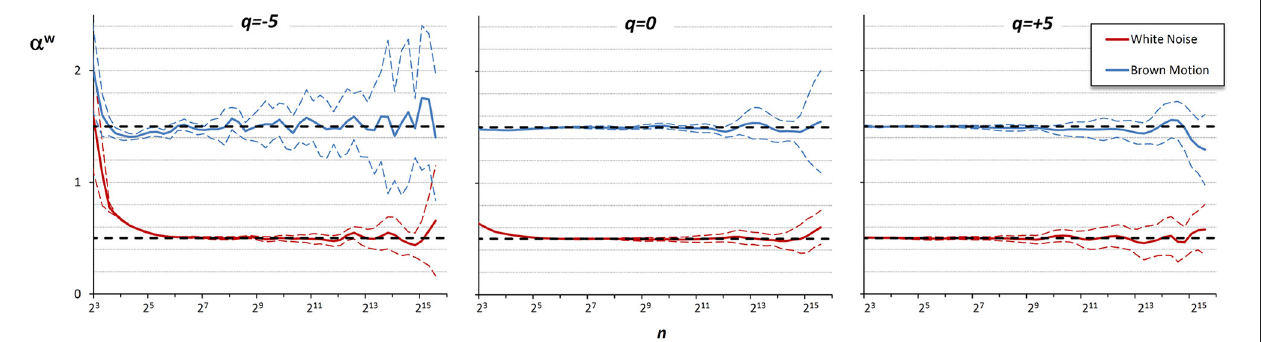
FIGURE 6 | Multifractal Multiscale coefficients by combining DFA 1 and DFA 2 . Weights defined by Equations (23a–c).